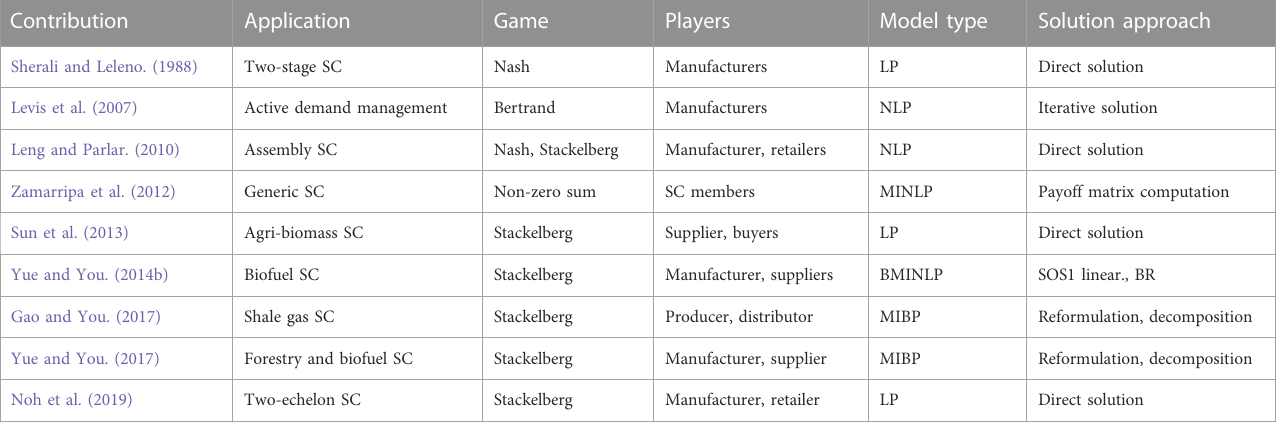
TABLE 1 Representative contributions of non-cooperative supply chain problems.